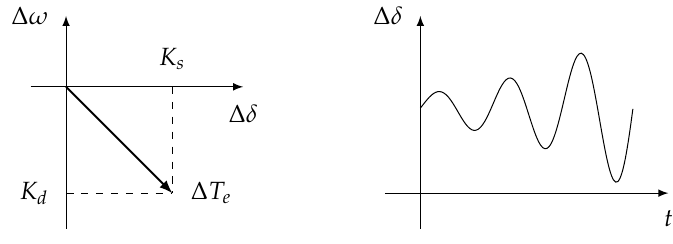
Figure 2. Complex plane of ∆ T e ( t ) and ∆ δ ( t ) response for unstable oscillatory condition.